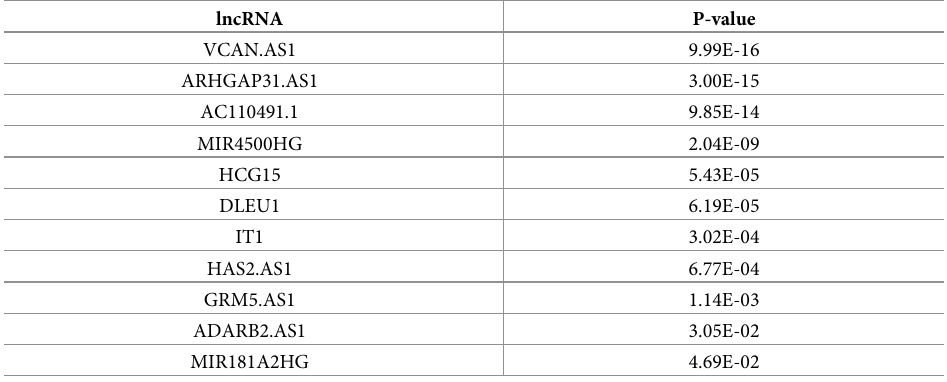
Fig 1. The ceRNA network. The colored circles represent key lncRNAs (with both green and yellow) and key hub lncRNAs (with green) (n � 3). https://doi.org/10.1371/journal.pone.0248634.g001 Table 1. P -values of the lncRNAs associated with the survival rate of glioma